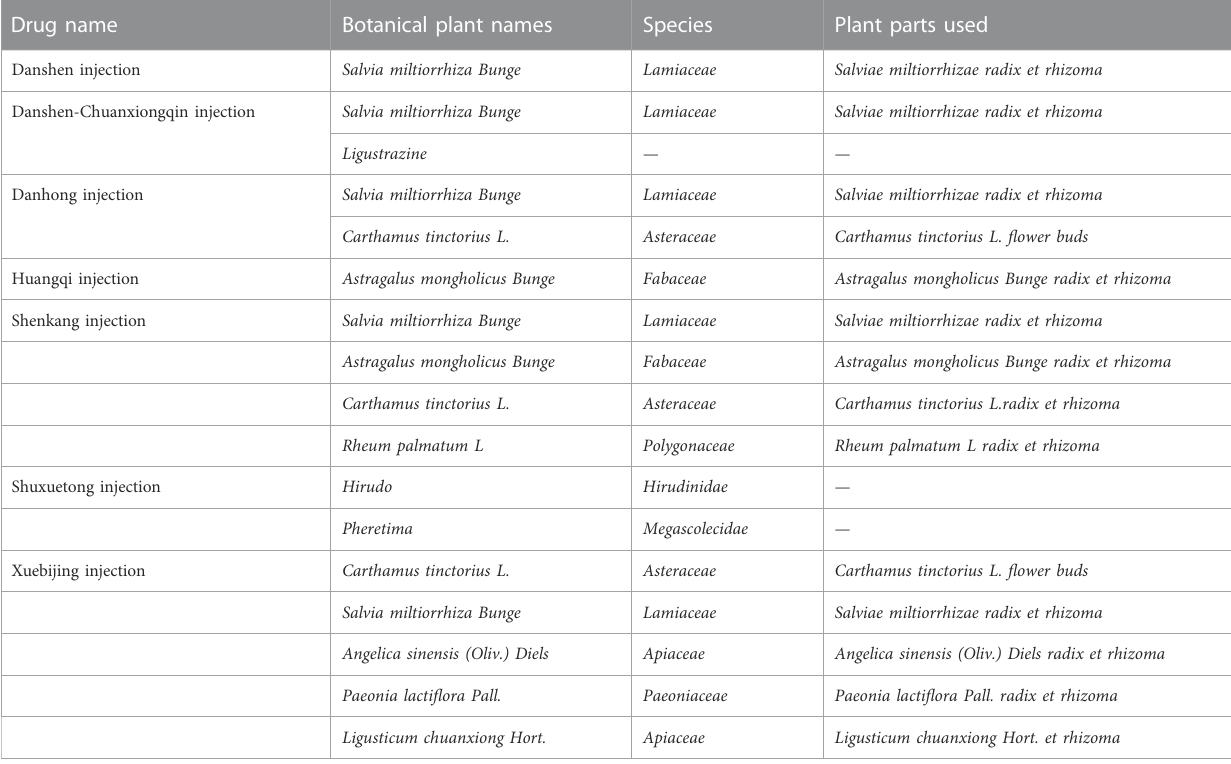
TABLE 1 Composition of the traditional Chinese medicine